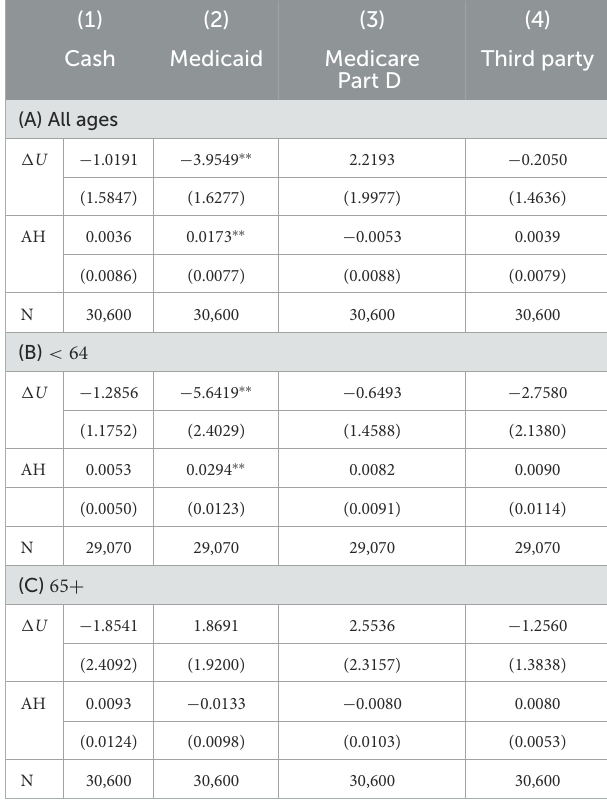
TABLE 4 OLS results.